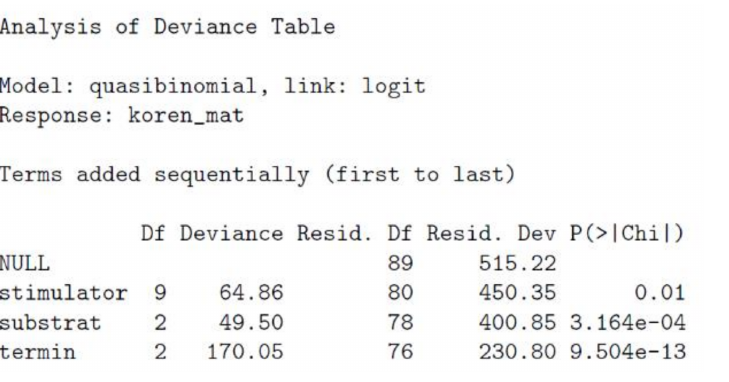
Figure A2. LR-test of the significance of factors for the proportion of rooted cuttings from the total number of